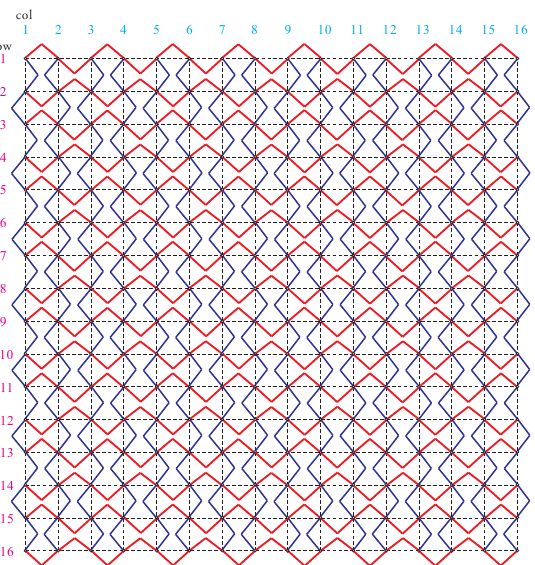
Figure 6. Arrangement of snake paths in G d from G g = G 16 × 16 ; thick triangle lines denote the snake paths of G d and horizontal or vertical dashed lines represent the enlarged paths of G (cid:48) g